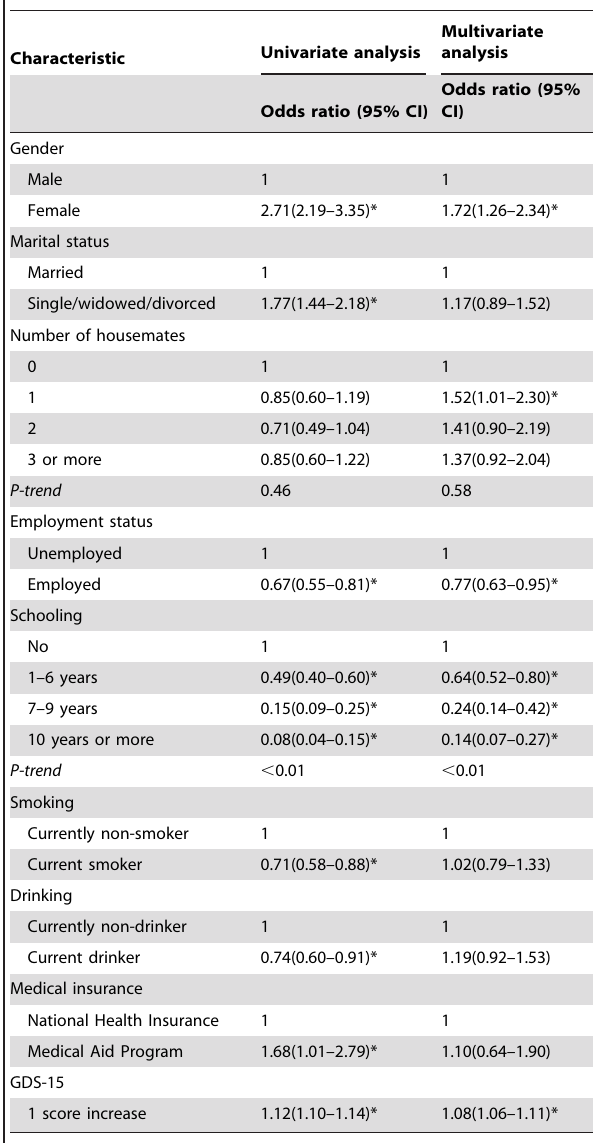
Table 3. Associations between socio-demographic variables and depression in adults aged 60–64 living in a rural area,